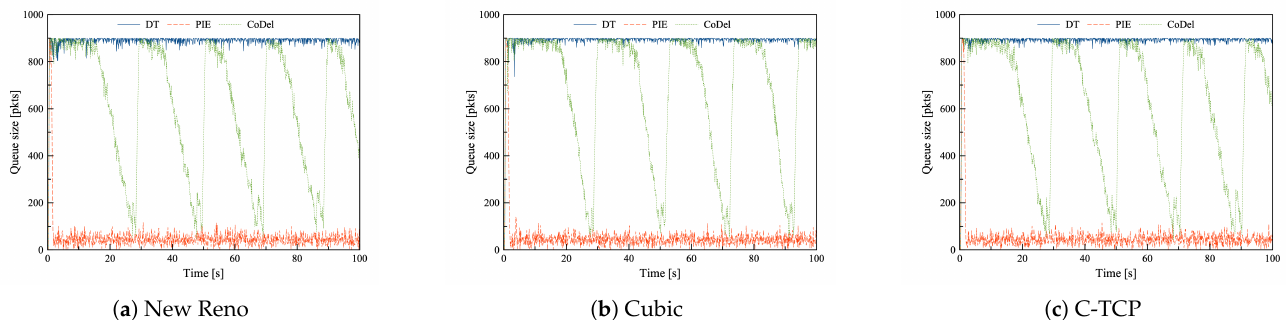
Figure 7. The queue length of DT, PIE and CoDel in combination with ( a ) New Reno, ( b ) Cubic, and ( c ) C-TCP in the Access Link scenario with common TCPs during heavy